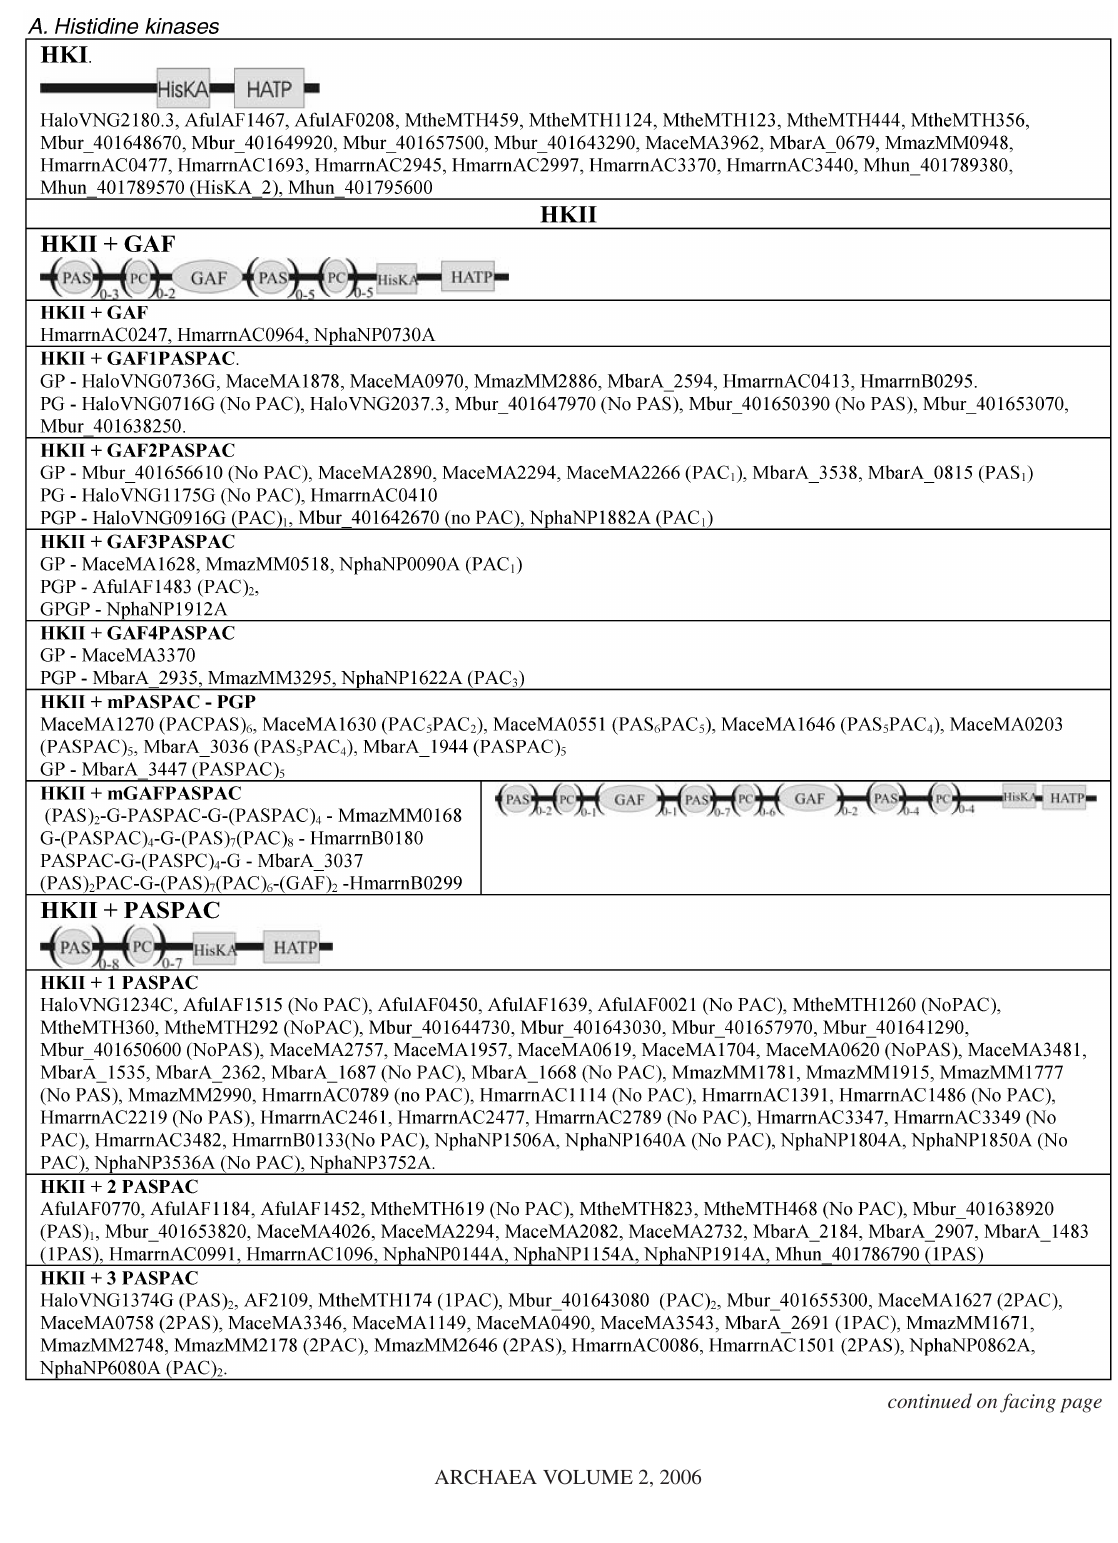
Table 2. Compilation and cartoon diagrams of all putative archaeal open reading frames encoding two-component proteins. Ab- breviations; Cach = Cache; ConA = ConA-like glucanase; Gly = Glycos_transf_2; HKA = His_KA (and KA2); HATP